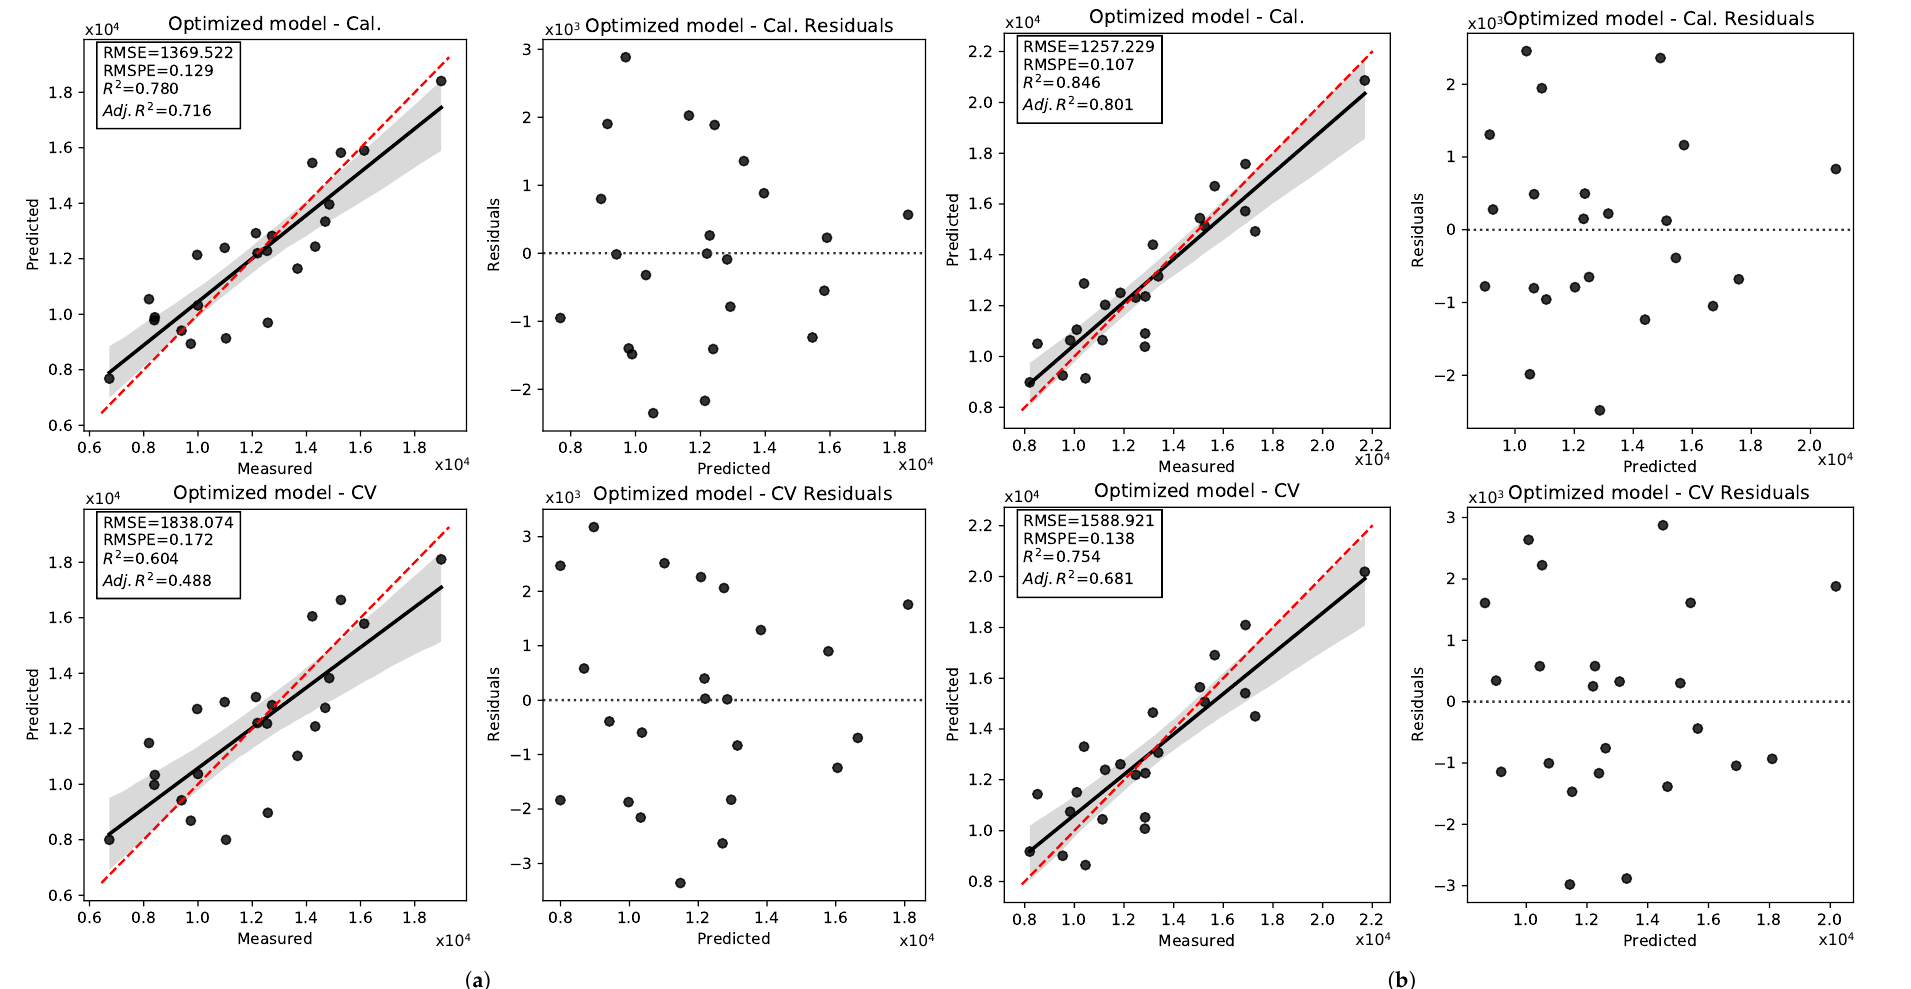
Figure 10. Regression results for snap bean 2019 data set on ( a ) the ACO-RENDVI model at 46 DAP for the early harvest stage and ( b ) the SA-SAM model at 48 DAP for the late harvest